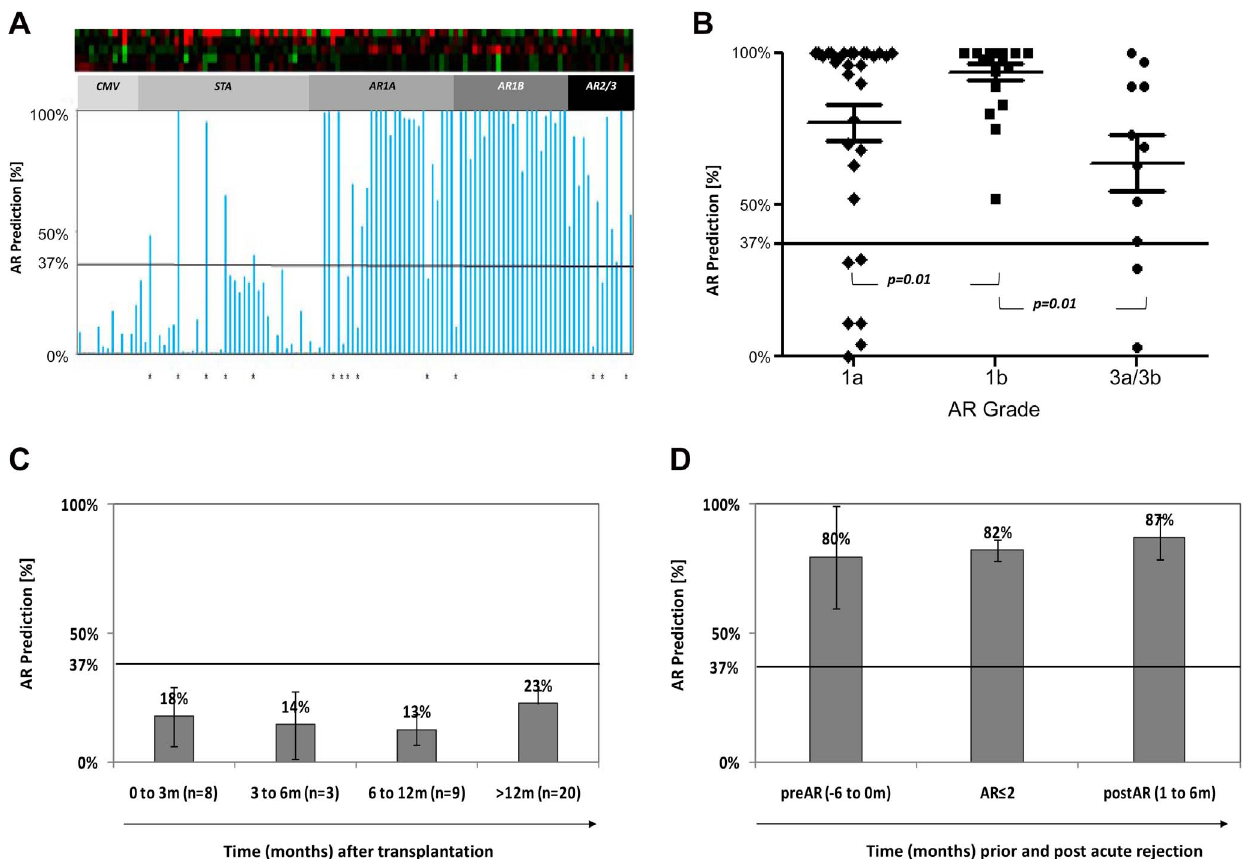
Figure 2. Predicted Probability of AR in 141 Peripheral Blood samples from Adult Heart Transplant Recipients. A. The predicted probability of a sample having a non-invasive diagnosis of AR, based on the logistic regression score on the 5-gene model is shown on the Y Axis